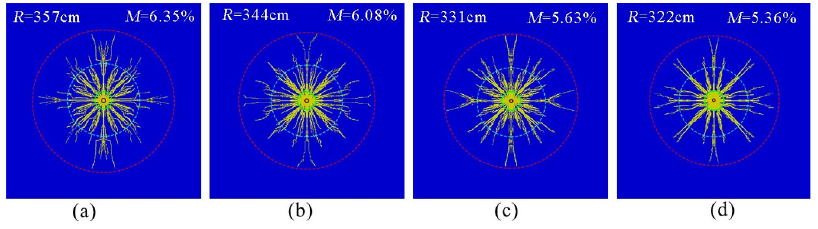
Fig 10. Crack distribution at different pore sizes. (a)Pore size 133 mm.(b)Pore size 113 mm.(c)Pore size 94 mm.(d) Pore size 75